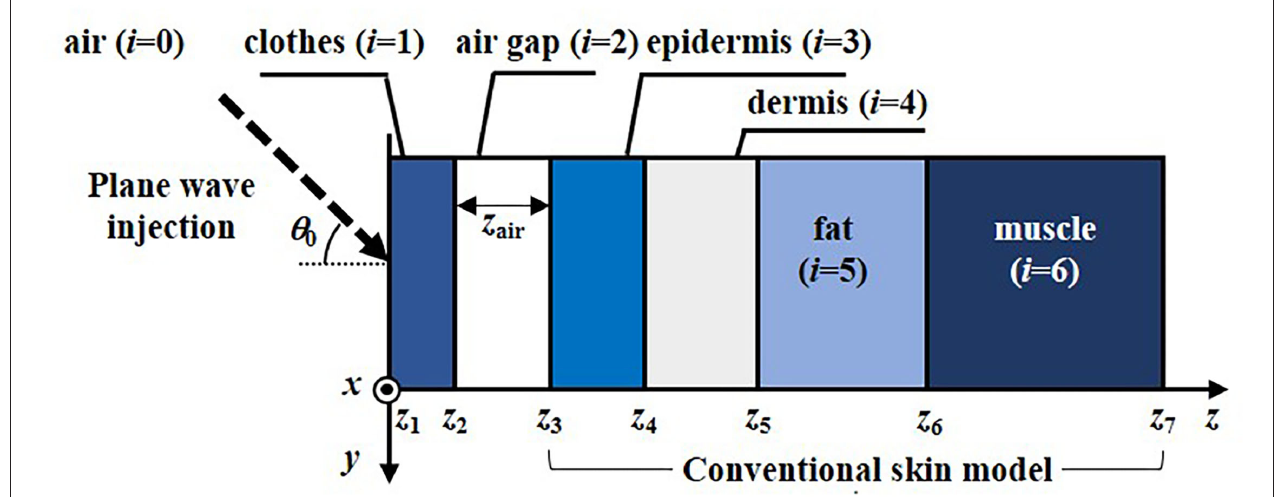
FIGURE 1 | Two-dimensional clothed skin model composed of various cloth material ( i = 1), air gap layer ( i = 2), epidermis ( i = 3), dermis ( i = 4), fat ( i = 5), and muscle ( i = 6) exposed to an obliquely incident plane wave.